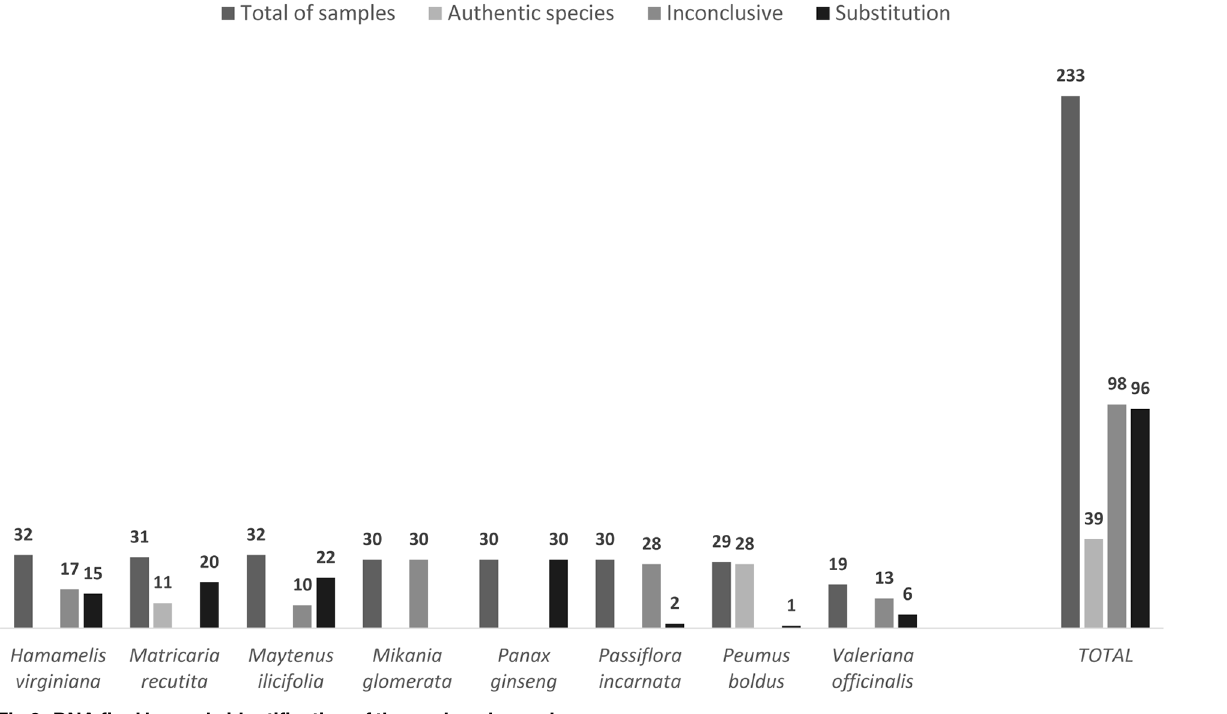
Fig 3. DNA final barcode identification of the analyzed